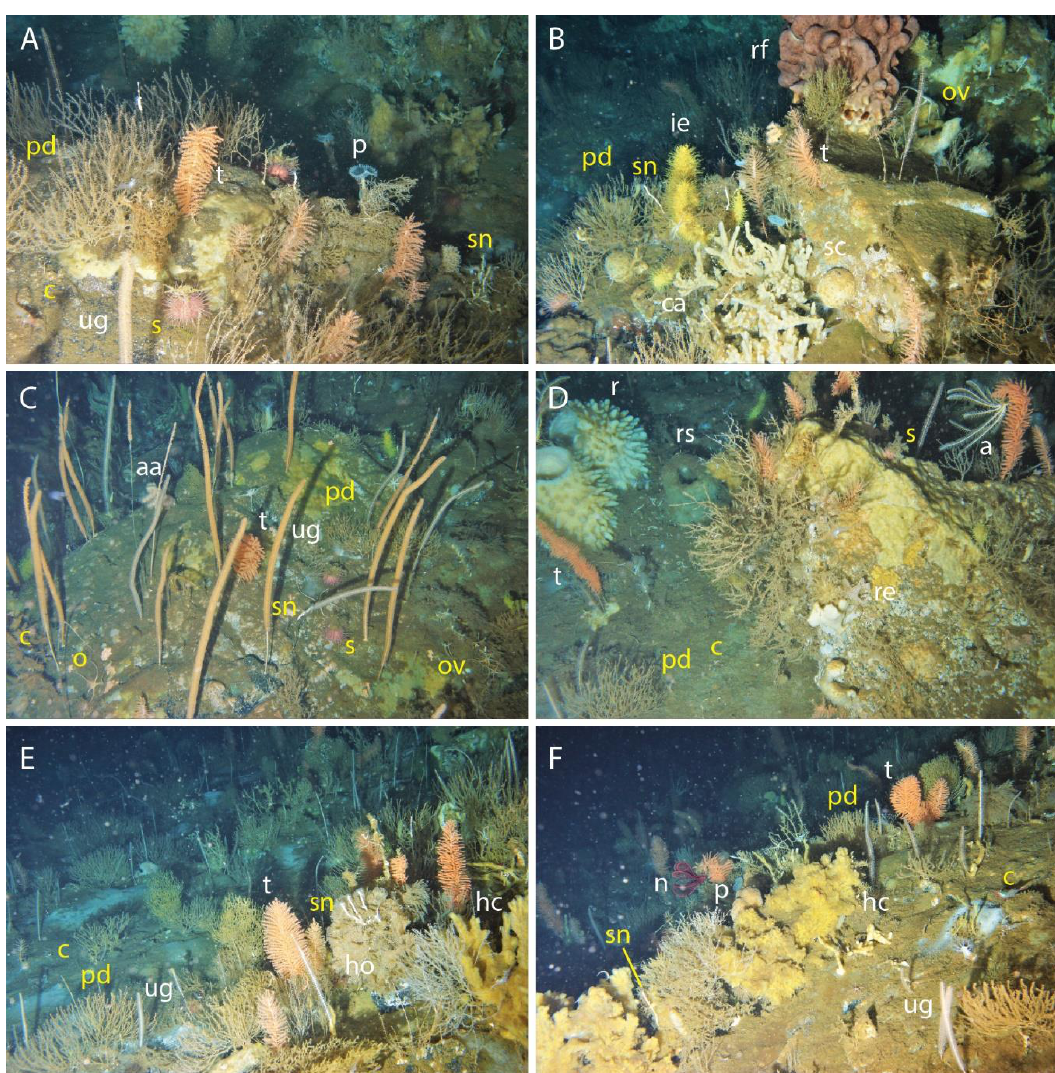
Figure 4 . Benthic assemblage at Terra Nova Bay “Canyon”. ( A ) Seafloor at 245 m characterized by hard substrates with a prevalence of the calcifier cnidarian Primnoisis ( Delicatisis ) delicatula (pd), specimens of genus Thouarella (t) and unbranched gorgonian (ug); other macrobenthic organisms included the polychaetes Serpula narconensis (sn) and Perkinsiana magalhaensis (p), the echinoid Sterechinus neumayeri (s) and the crustacean Chorismus antarcticus (c); ( B ) assemblage at 265 m comprising the sponges Calyx arcuarius (ca), Isodyctia erinacea (ie) and Suberites caminatus (sc); the cnidarians Primnoisis ( Delicatisis ) delicatula (pd); and specimens of genus Thouarella (t), Serpula narconensis (sn) and Ophiacantha vivipara (ov); ( C ) hard substrate at 248 m with high densities of unbranched gorgonians (ug), Primnoisis ( Delicatisis ) delicatula (pd), Alcyonium antarcticus (aa) and Thouarella sp. (t); other noticeable components are Serpula narconensis (sn), Sterechinus neumayeri (s), ophiuroids such as Ophiancantha vivipara (ov) and Ophiura sp. (o) and the Chorismus antarcticus (c), these latter all concurring to the calcifier fauna; ( D ) assemblage at 267 m composed by the sponges Rossella sp. (r) and Rossella nuda (rn), cnidarians represented by the calcifier Primnoisis ( Delicatisis ) delicatula (pd) and specimens of the genus Thouarella (t), together with bryozoans as Reteporella sp. (re); Sterechinus neumayeri (s) and Chorismus antarcticus (c) represent the vagile fauna; ( E ) bottom at 272 m colonized by Primnoisis ( Delicatisis ) delicatula (pd), Thouarella sp. (t), unbranched gorgonians (ug) and sponges Haliclona sp. (hc); among the calfiers, individuals of Serpula narconensis (sn) fouling the bryozoan Hornera sp. (ho) and the crustancean Chorismus antarcticus (c) were observed; note whitish patches of decaying organic matter; ( F ) hard bottom at 281 m colonized by sponges Haliclona sp. (hc), Primnoisis ( Delicatisis ) delicatula (pd), Thouarella sp. (t) and unbranched gorgonians (ug); note the serpulids Perkinsiana magalhaensis (p) and Serpula narconensis (sn), the crinoid Notocrinus virilis (Mortensen, 1917) (n) and Chorismus antarcticus (c). Yellow letters refer to calcifier